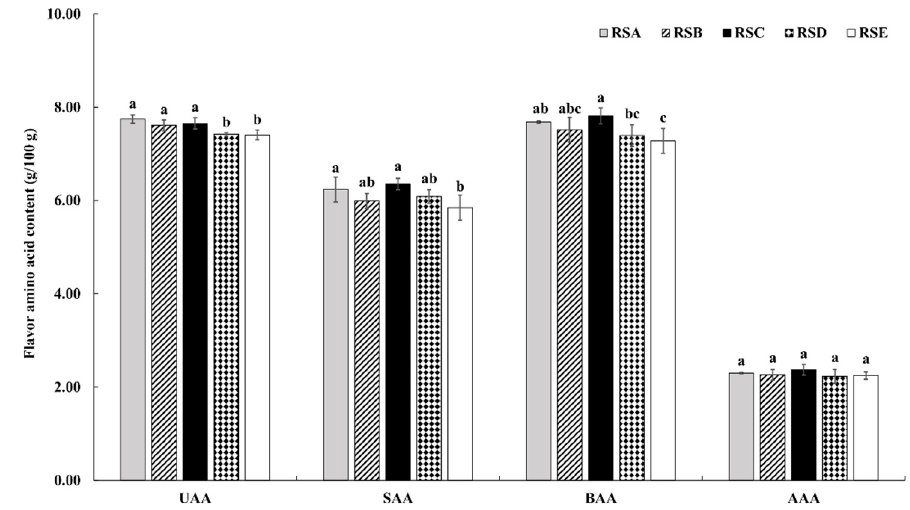
Figure 4. Flavor amino acid composition of M. importuna under different rotation systems. UAA, umami amino acid; SAA, sweet amino acid; BAA, bitter amino acid; AAA, aromatic amino acid; different letters indicate a statistical difference ( p < 0.05). Table 4. Flavor amino acid proportion of M. importuna under different rotation systems.